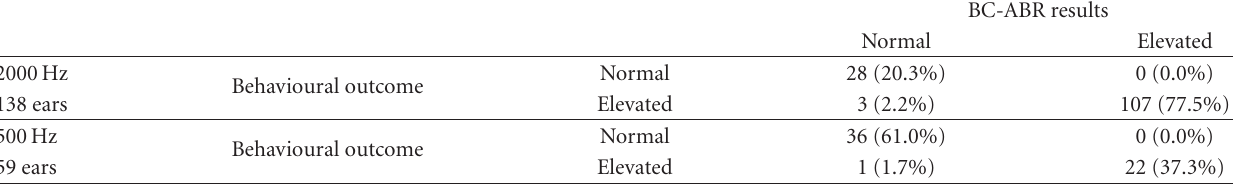
Table 1: Accuracy of “normal” BC-ABR levels for classification of “normal” versus “elevated” cochlear